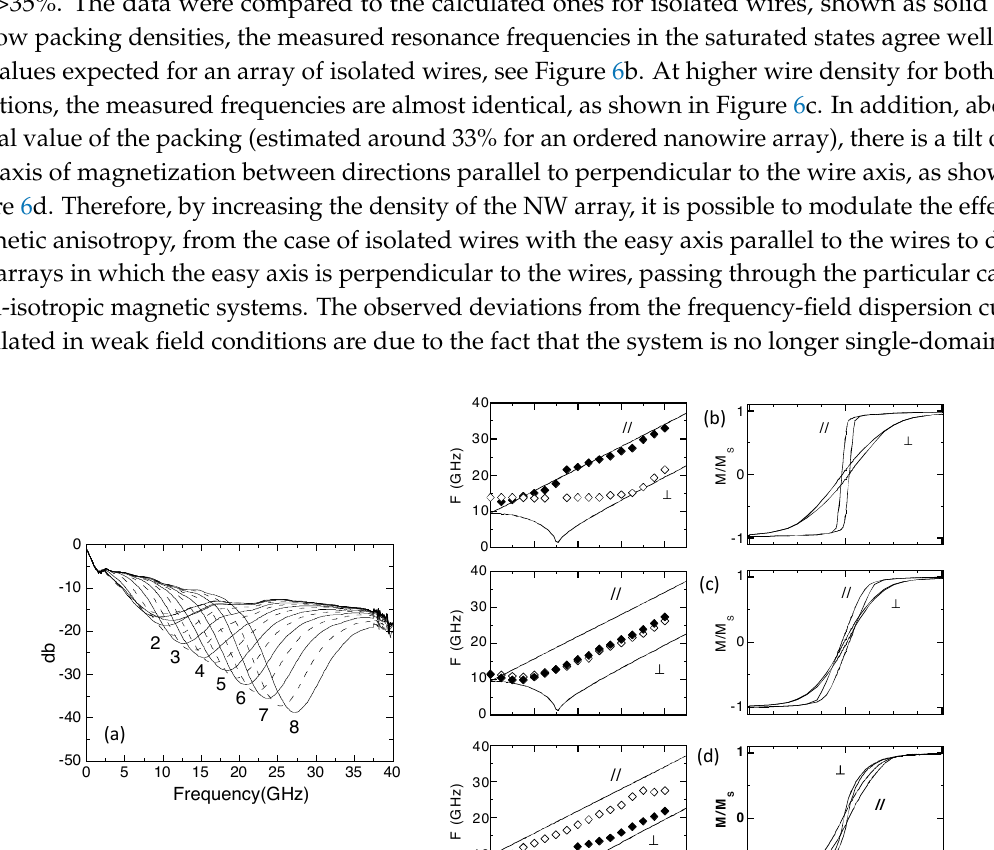
FIGURE 2 A. Encinas-Oropesa, et. al. J. Appl. Phys.